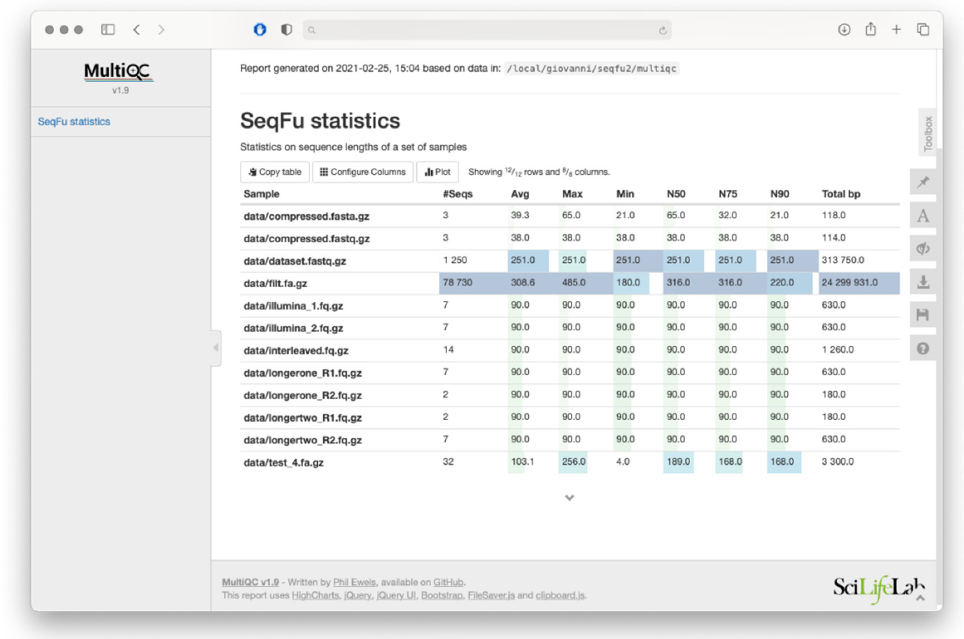
Figure 2. MultiQC report generated by seqfu stats . Furthermore, seqfu counts can generate a similar table.